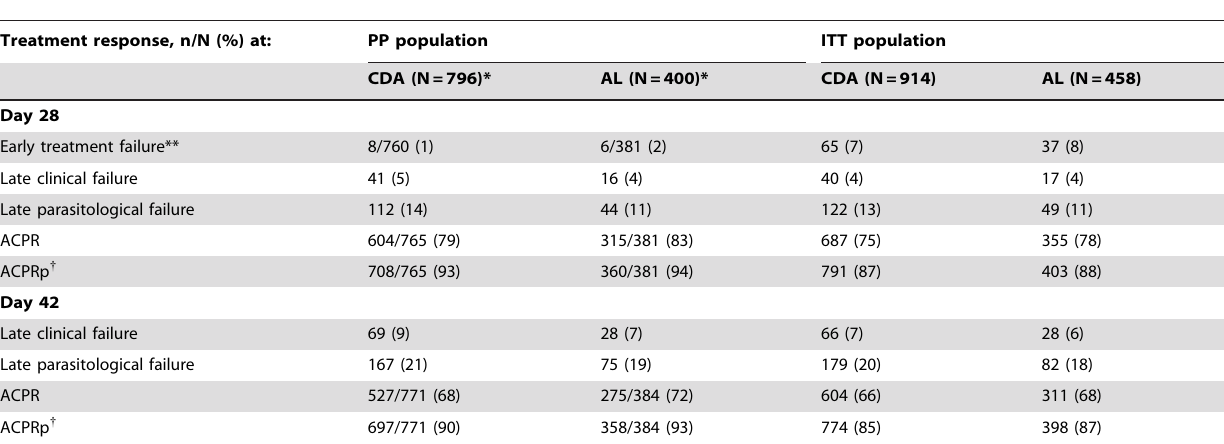
Table 4. WHO-defined 2003 endpoints for assessing antimalarial therapy: ACPR and ACPRp.